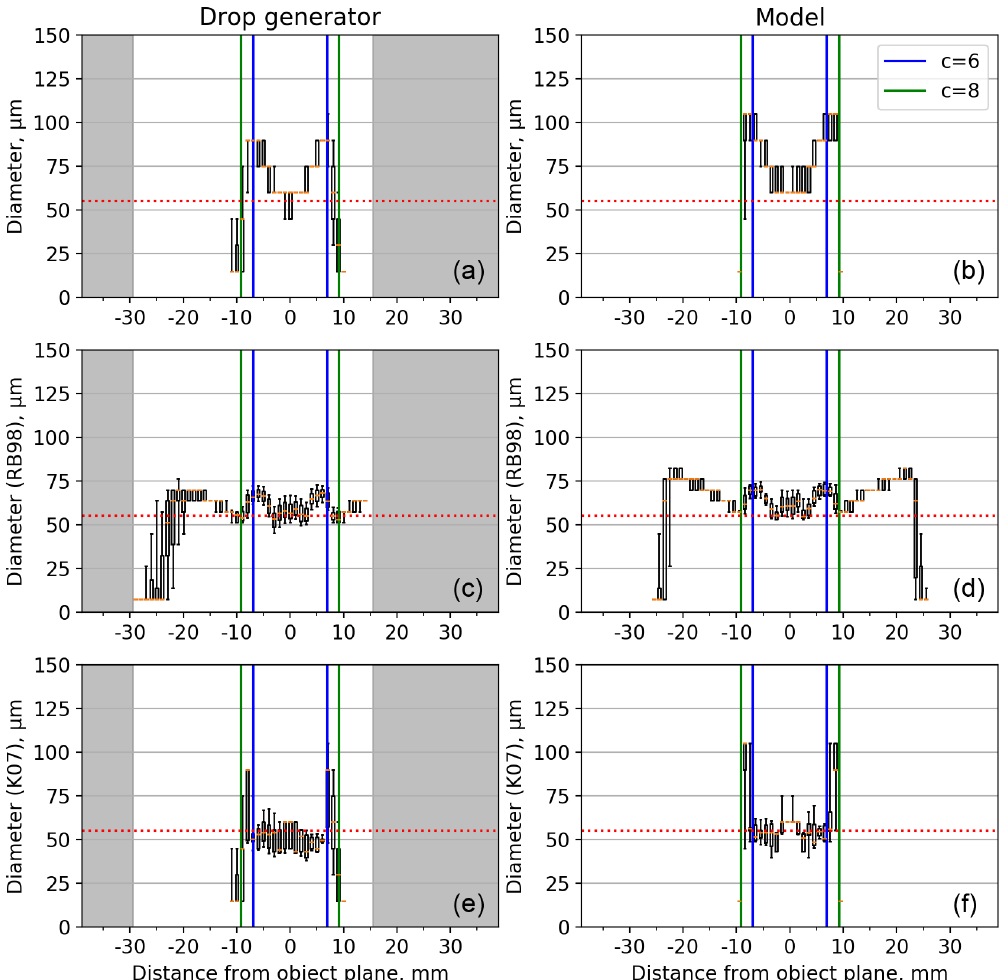
Figure 2. Box and whisker plots showing image diameter as a function of distance from the object plane. Orange markers are the median diameter, boxes are the 25 and 75th percentiles and the whiskers are the 10 and 90th percentiles. Panels (a) , (c) and (e) show results from the laboratory experiments using a 60µm printhead. The grey-shaded regions were not sampled using the drop generator. Panels (b) , (d) and (f) show the model image diameter from a 55µm particle. Panels (a) and (b) show the image diameter using a 50% decrease in intensity threshold ( D 50 ). Panels (c) and (d) show the diameter after the Reuter and Bakan (1998) size correction has been applied. Panels (e) and (f) show the diameter corrected using the Korolev et al. (2007) algorithm. Dashed red lines show the droplet diameter estimated by comparing the laboratory measurements with the synthetic data. The position of the depth of field calculated using Eq. (1) with c values of 6 (blue) and 8 (green) are shown as vertical lines. Table 2. Median (interquartile range) image diameter for Z d < 6 from the drop generator experiments and the model images. Drop generator Model